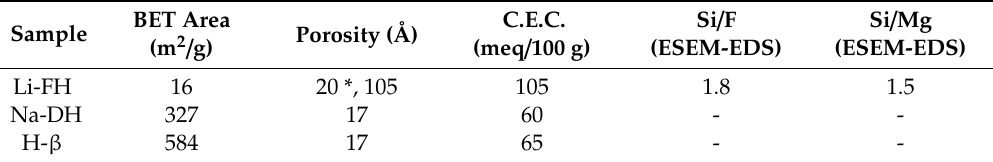
Table 2. Characterization of Li-FH, Na-DH and H- β samples.